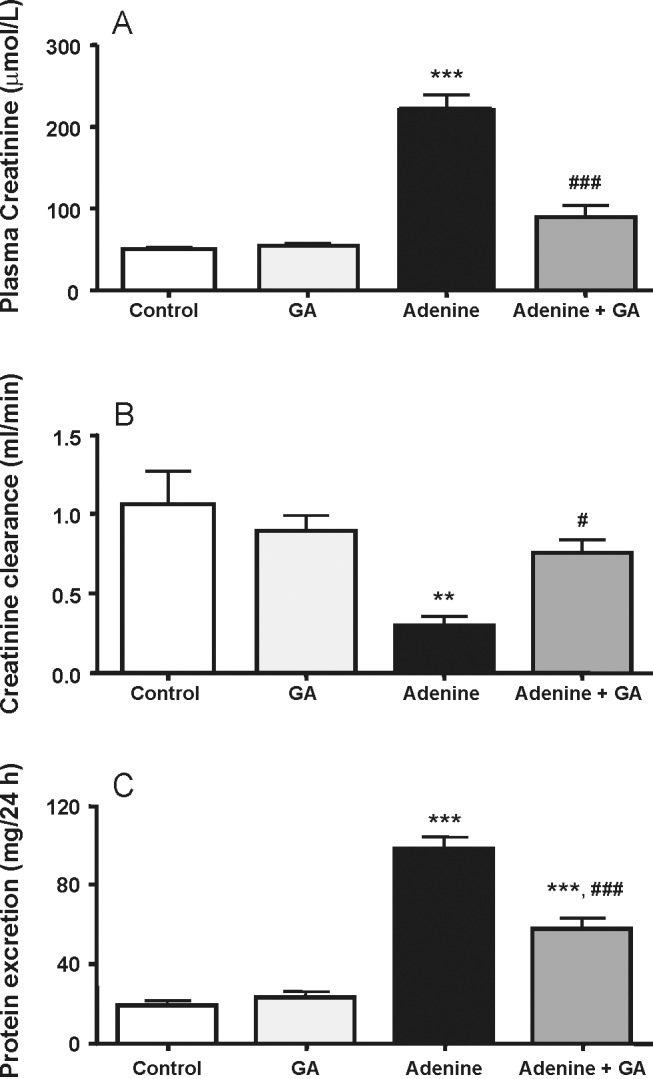
Plasma creatinine (A) and creatinine clearance (B), as well as proteinuria (C) in control rats, rats treated with gum arabic (15% w/v in drinking water) and rats treated with adenine (0.75% w/w) alone in feed, or with adenine and gum arabic given concomitantly at the same dose for 28 days.Each column and vertical bar represents the mean ± SEM (n = 6). ** p<0.01, *** p<0.001 vs. control, # p≤0.05, ### p<0.001 vs. adenine treatment.